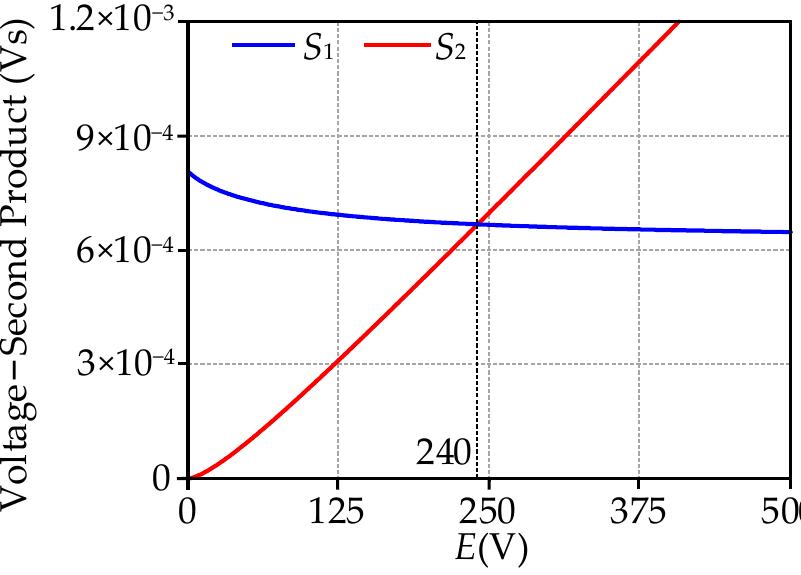
Figure 9. The curves of S 1 and S 2 .